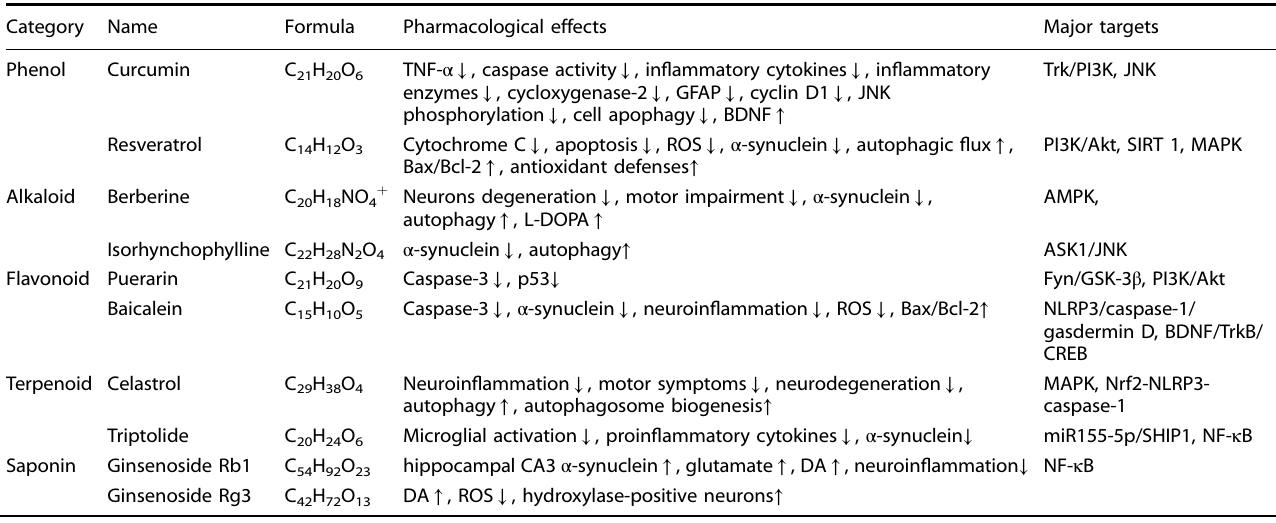
Table 3. Natural compounds with therapeutic potential for PD treatment